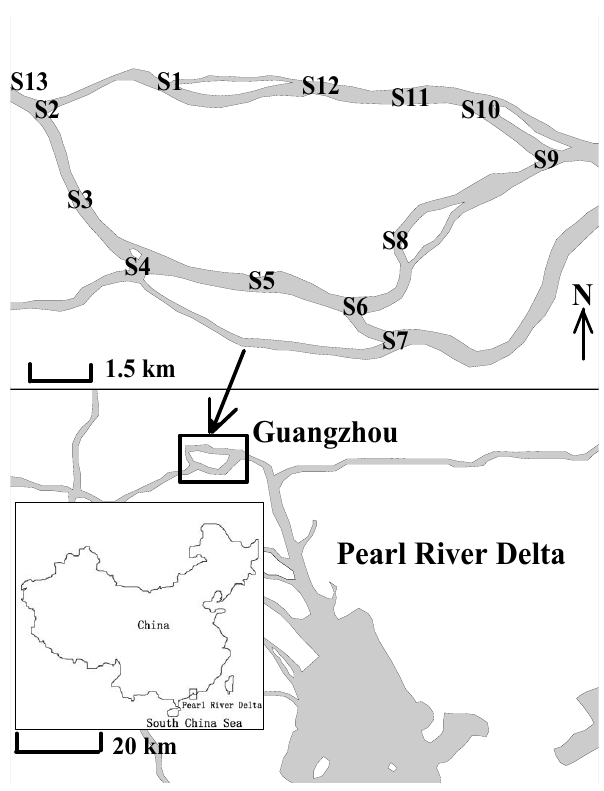
Fig. 1 Fig. 1. Sampling stations along the Guangzhou reaches of the Pearl River Estuary, South China: S1 (Ersha Island), S2 (Bai- etan), S3 (Hedong Bridge), S4 (Yuxi Community), S5 (Luoxi Bridge), S6 (Xiaozhou Village), S7 (Nansha Express), S8 (Lun- touhai), S9 (Emei Zhou), S10 (Xinchong Kou), S11 (Linjiang Road), S12 (Liede Village), S13 (Huadi